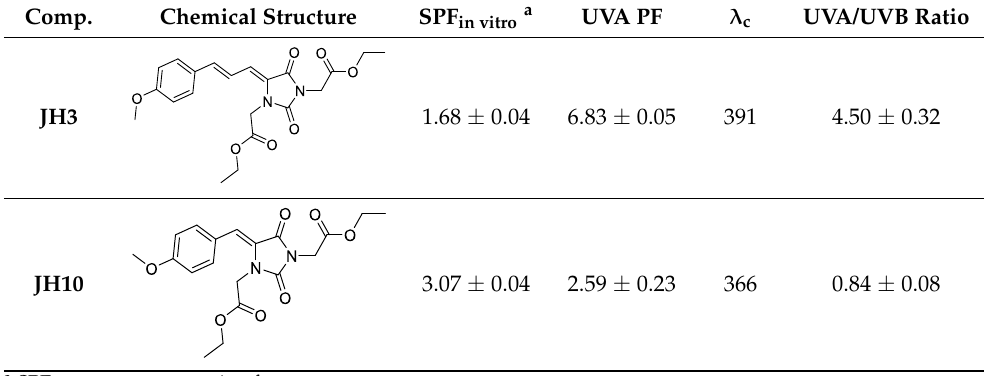
Table 1. Chemical structures and photoprotective activity of the title compounds obtained in 2% ( w / w ) macrogol formulations. Comp.